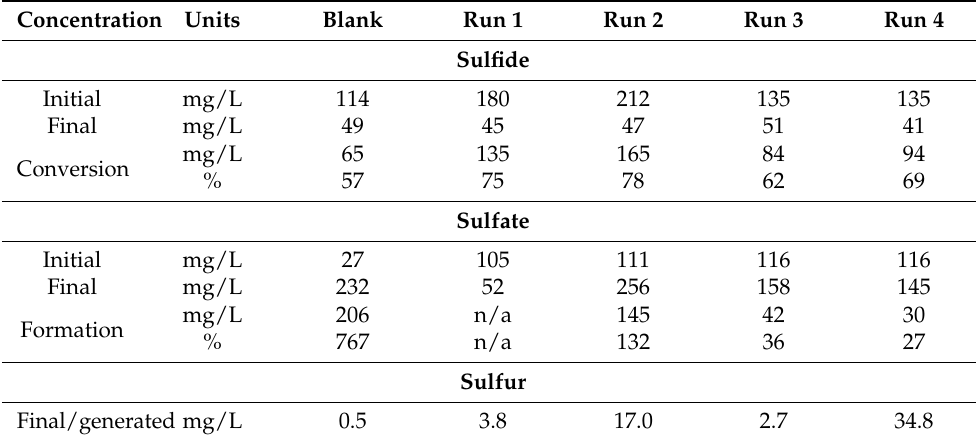
Table 3. Sulfide, sulfate, and sulfur concentration in the immobilized cells experiment. Concentration